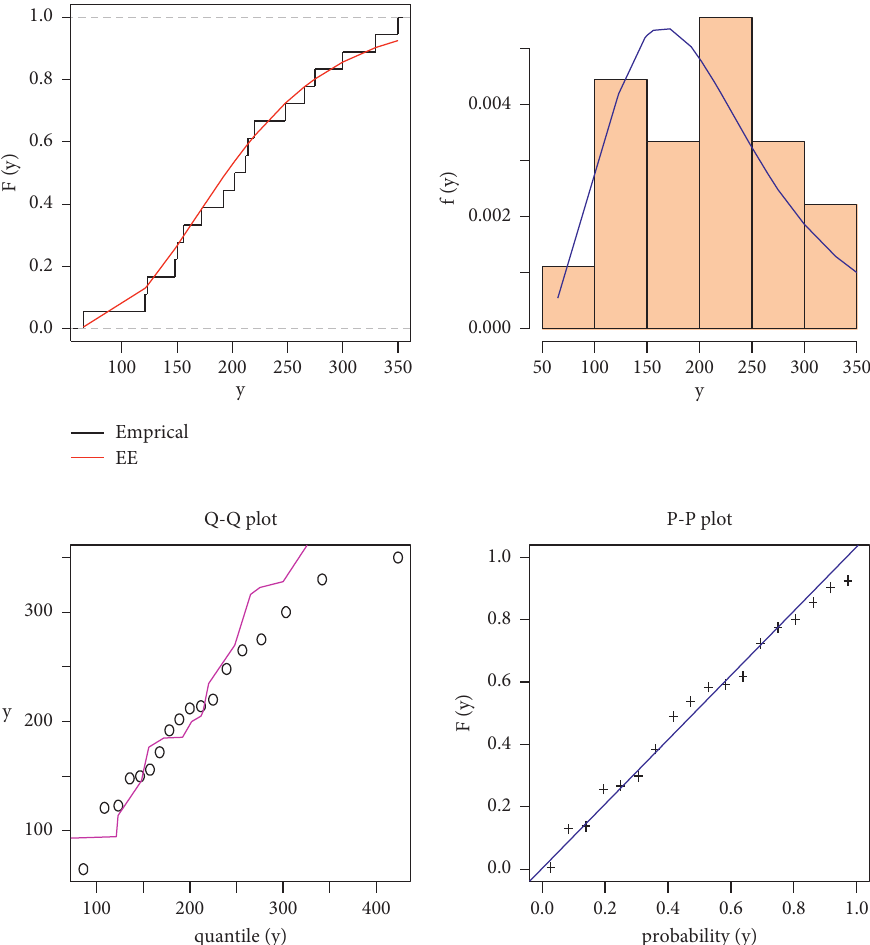
Figure 4: The fitted pdf, cdf, PP plot, and QQ plot for EE distribution for the second